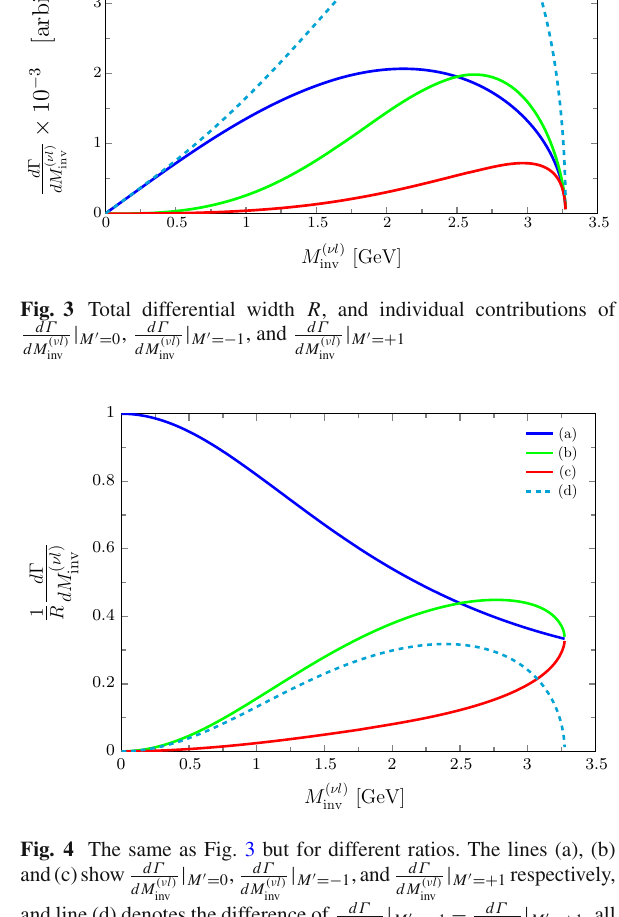
d Γ d Γ | | | M (cid:7) = 0 , M (cid:7) =− 1 ,and M (cid:7) =+ 1 respectively, dM (ν l ) inv dM (ν l ) inv dM (ν l ) inv | − d Γ | M (cid:7) =− 1 M (cid:7) =+ 1 , all dM (ν l ) inv dM (ν l ) inv